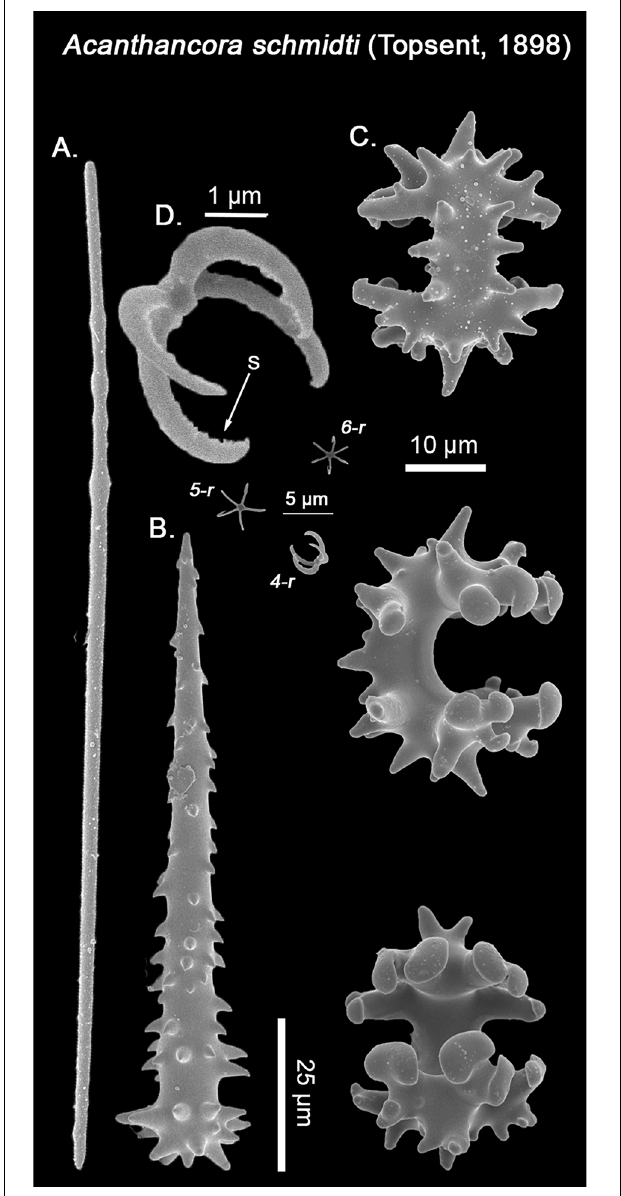
FIGURE 8 | SEM imagining of Acanthancora schmidti spicular set. (A) Strongyle with polytylote processes; (B) Acanthostyle. (C) Rear, lateral and frontal view of the acanthose chelae; (D) . Four-rayed ( 4-r ), five-rayed ( 5-r ), and six-rayed ( 6-r ) chiastosigmas, with a close up of a four-rayed chiastosigma, with visible serrulated shafts (S). Scale bar for (A–C) 25 µ m; Scale bar for (D) , close up chiastosigmas 1 µ m, and scale bar for (D) , general view of the chiastosigmas types, 5 µ